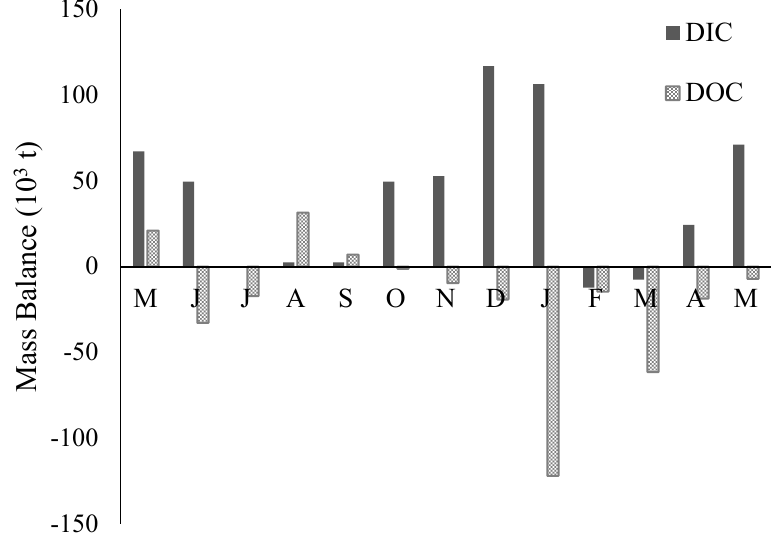
Figure 8. DIC and DOC monthly mass balance in the Atchafalaya River Basin (Mass Balance = monthly export from outlets − monthly input at Simmesport). Positive values indicate mass load increase from inflow to outflow.